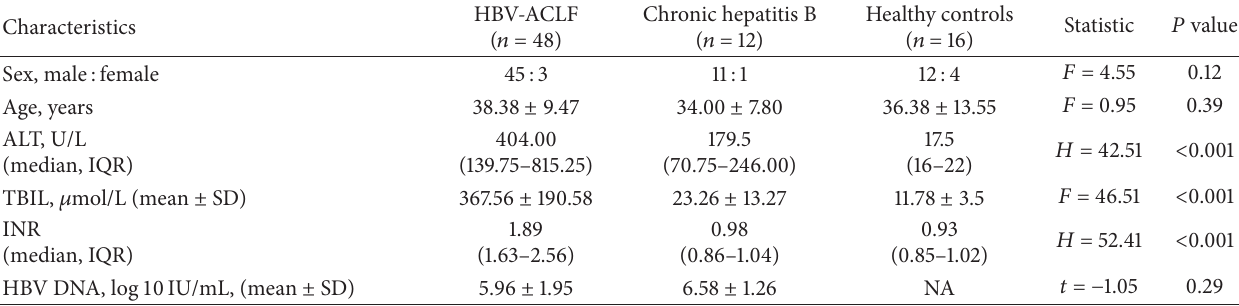
Table 1: Baseline characteristics of patients with hepatitis B-related acute-on-chronic liver failure (HBV-ACLF), patients with chronic hepatitis B, and healthy